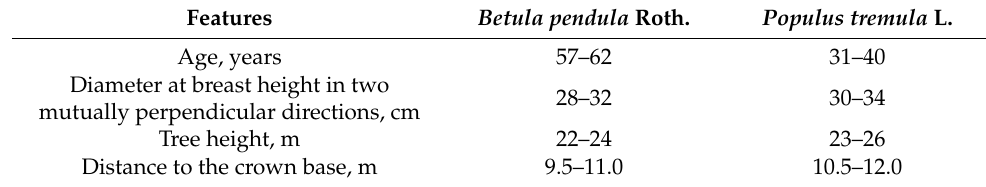
Table 1. Characteristics of model trees selected for the study.